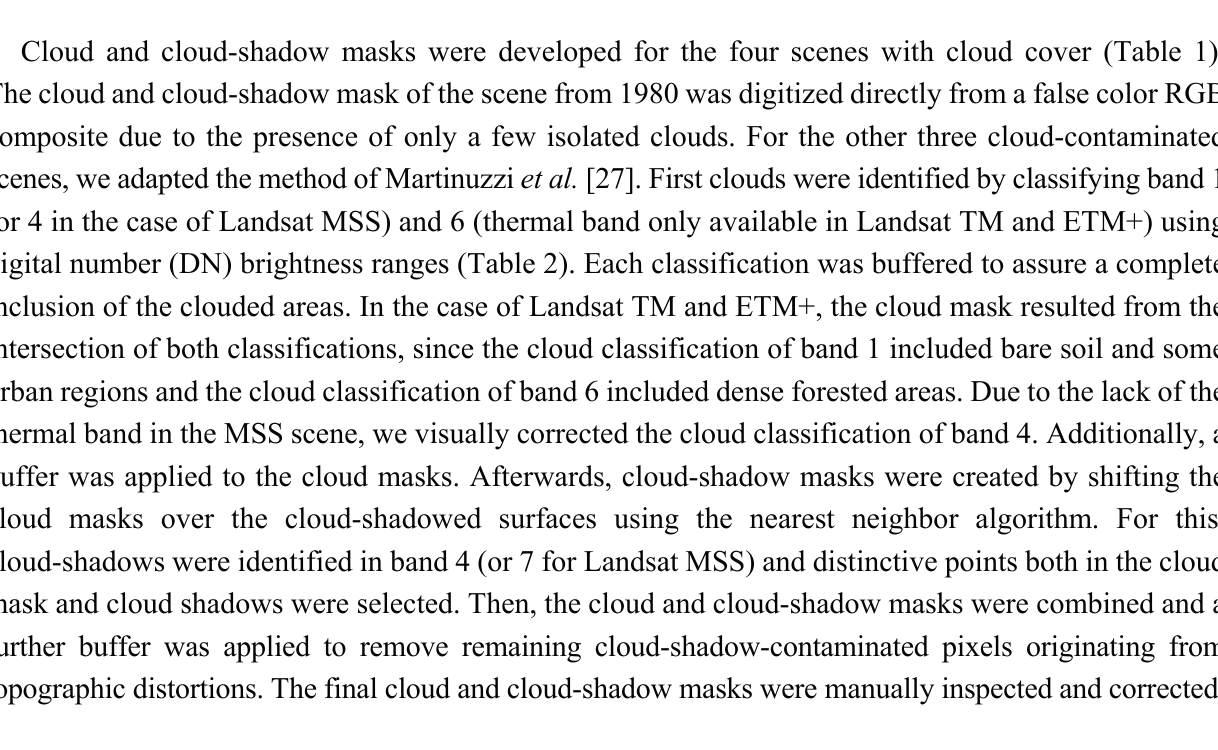
Table 2. Digital number (DN) brightness ranges and buffer size for the cloud and cloud-shadow masking. Band 1 corresponds to the Landsat TM scenes of 1987 and 2000, and band 4 corresponds to the Landsat MSS scene of